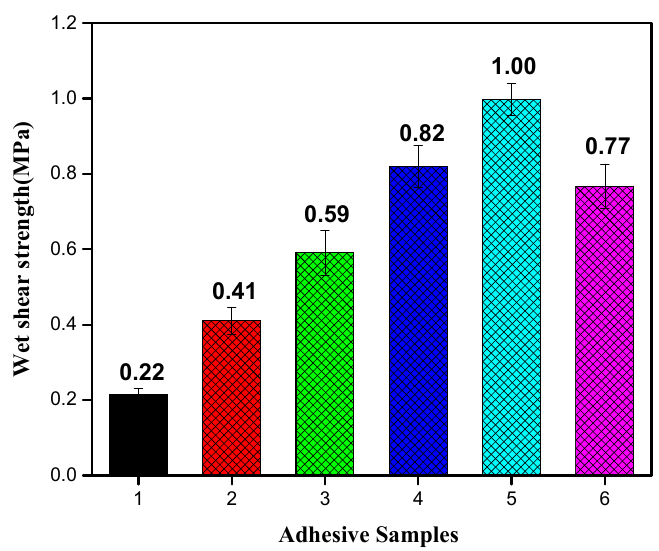
Figure 7. Shear strengths of the plywood prepared using various adhesives. 1: SM, 2: SM / TGIC, 3: SM / TGIC / DAS-5, 4: SM / TGIC / HD-2.5, 5: SM / TGIC / HD-5, and 6: SM / TGIC / HD-7.5.